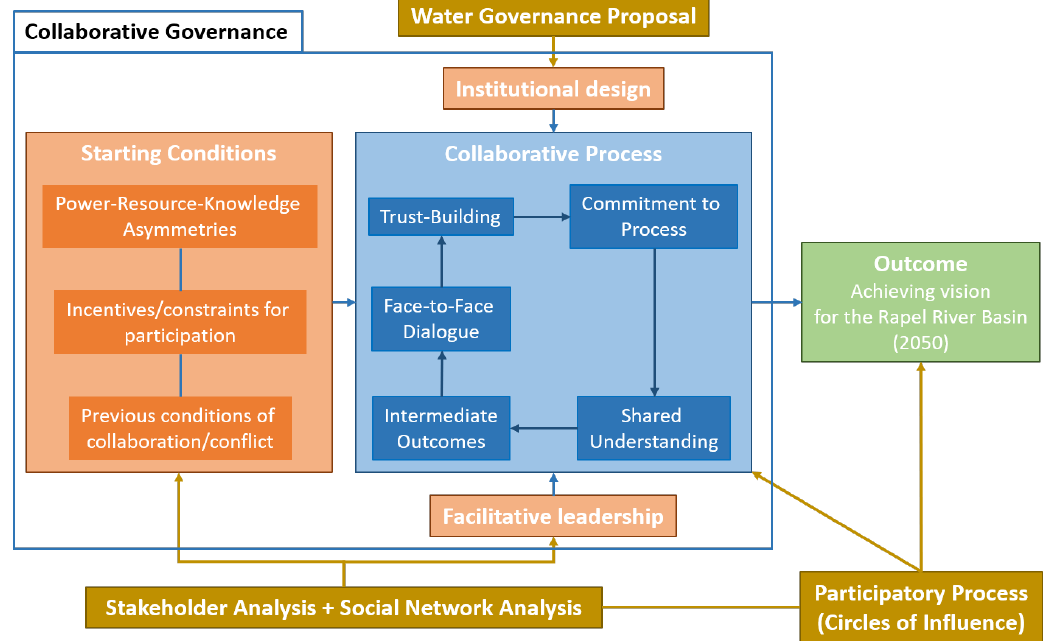
Figure 2. Methodological framework used in this article: three-tiered approach (SA, SNA and PP) and theoretical collaborative governance framework of Ansell and Gash (2008) (adapted from